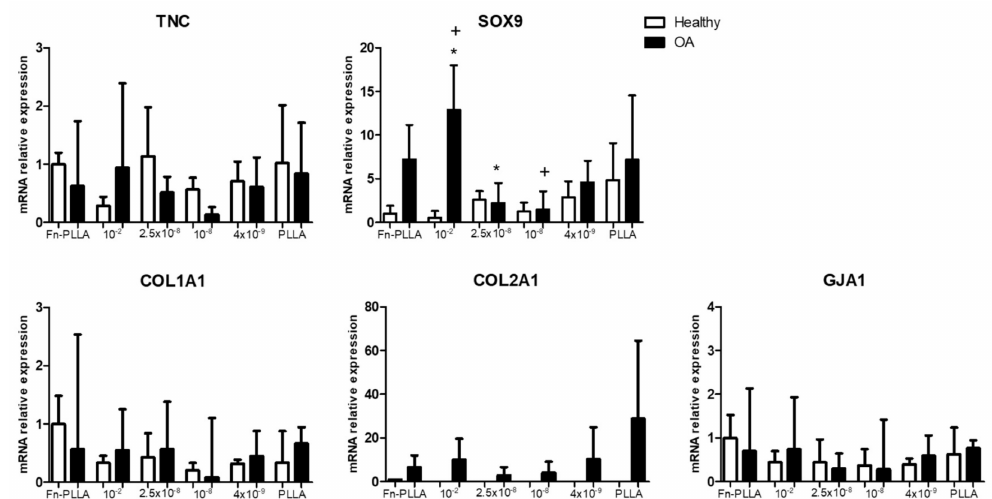
Figure 5. mRNA relative expression of TNC, SOX9, COL1A1, COL2A1, and GJA1 from H-(white) and OA-(black) derived BM-MSC aggregates formed in RGD-Cys-D1 PLLA nanopatterned substrates (10 − 2 , 2.5 × 10 − 8 , 10 − 8 , and 4 × 10 − 9 ), fibronectin-coated PLLA (Fn-PLLA), and untreated PLLA (PLLA), after three days, under CM. Values are given as the mean of three donors with standard deviation. * + indicate p <